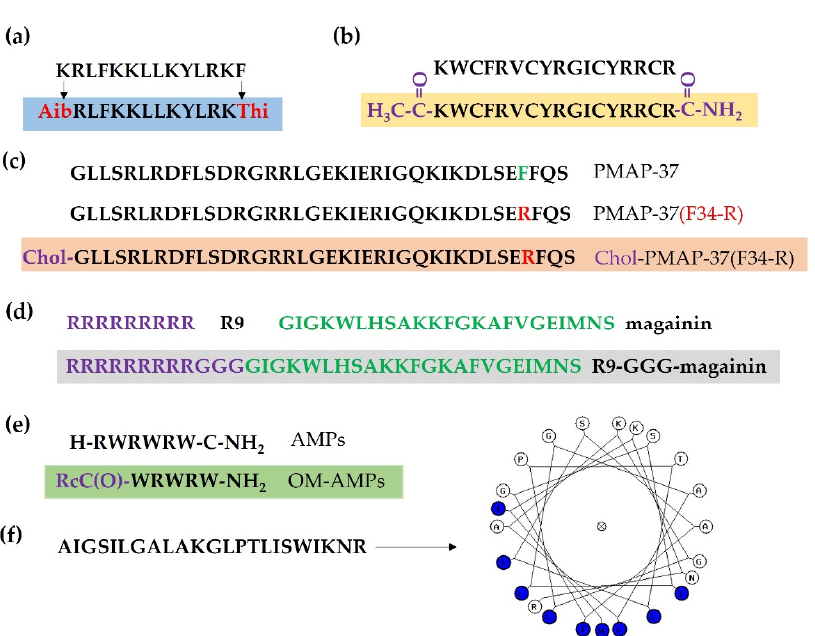
Figure 3. Modification of antimicrobial peptides (AMPs). ( a ) Substitution natural L-amino acids with D- or unnatural amino acids. Aib and Thi denote 4-aminobutanoic acid and L-thienylalanine, respectively. ( b ) N-terminal acetylation and C-terminal amidation of tachyplesin I. ( c ) N-terminal cholesterol-modified peptide PMAP-37 (F34-R). ( d ) Conjugation of R9 (RRRRRRRRR) with magainin (GIGKWLHSAKKFGKAFVGEIMNS) with three glycines (Gly, G). ( e ) Organometallic AMPs (OM-AMPs). ( f ) Design of a helical structure of AMP.